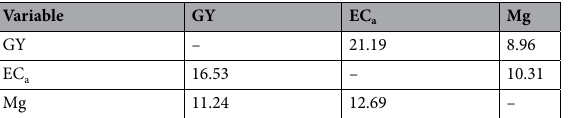
Table 2. Summary of analysis of variance results for maize grain yield obtained in a validation plot with variable rate seeding versus conventional seeding (recommended population).